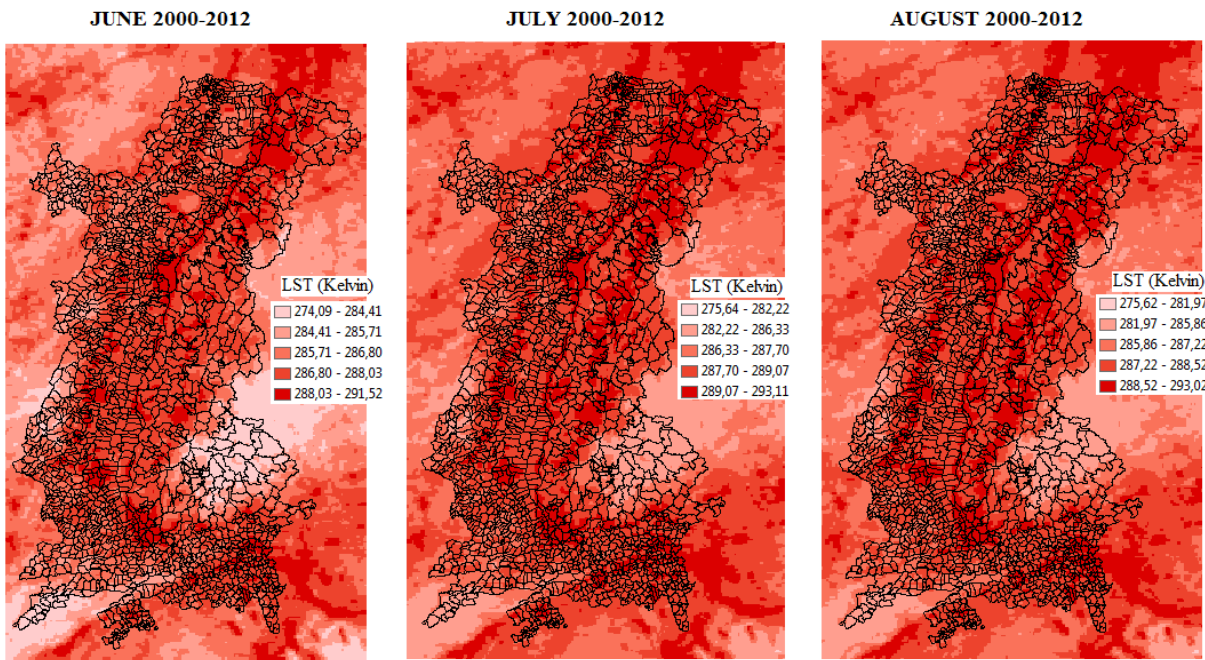
Figure 2. Average monthly land surface distribution (LST) (Kelvin), based on time series analysis of 13 years in